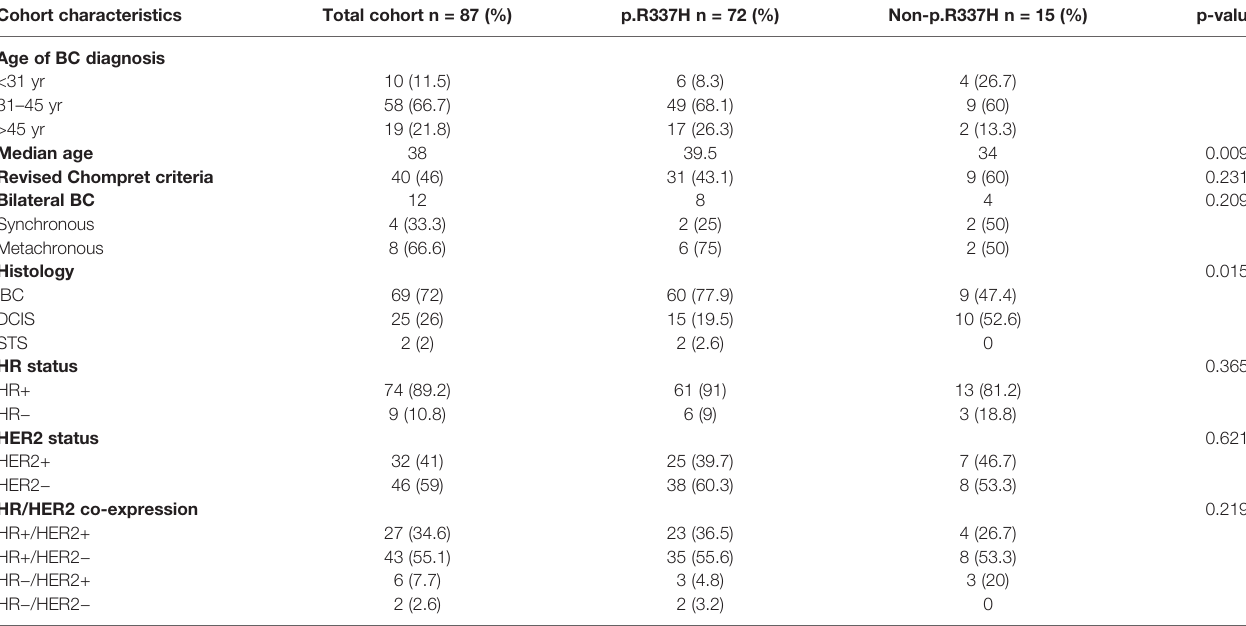
TABLE 1 | Clinical and pathological characteristics of p.R337H and non-p.R337H